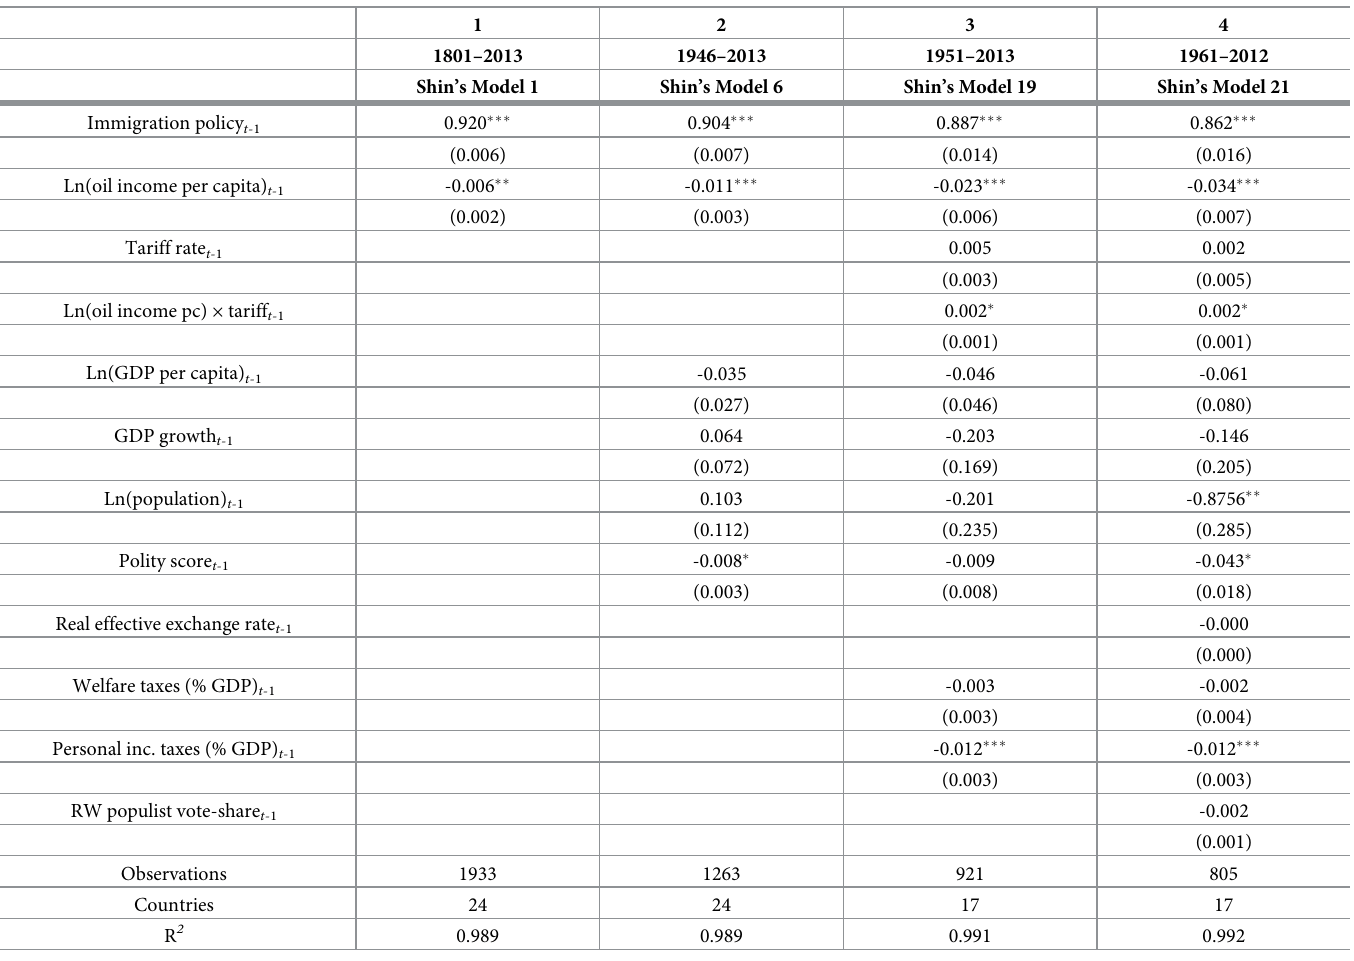
Table 1. Oil wealth and immigration policy: